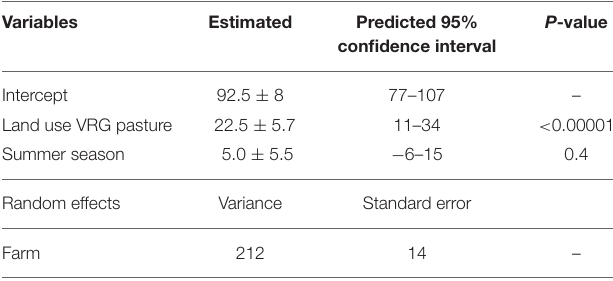
TABLE 3 | List of investigated parameters with coefficients, predicted 95% confidence intervals, standard errors, and p -values from the statistical models described in the paper.